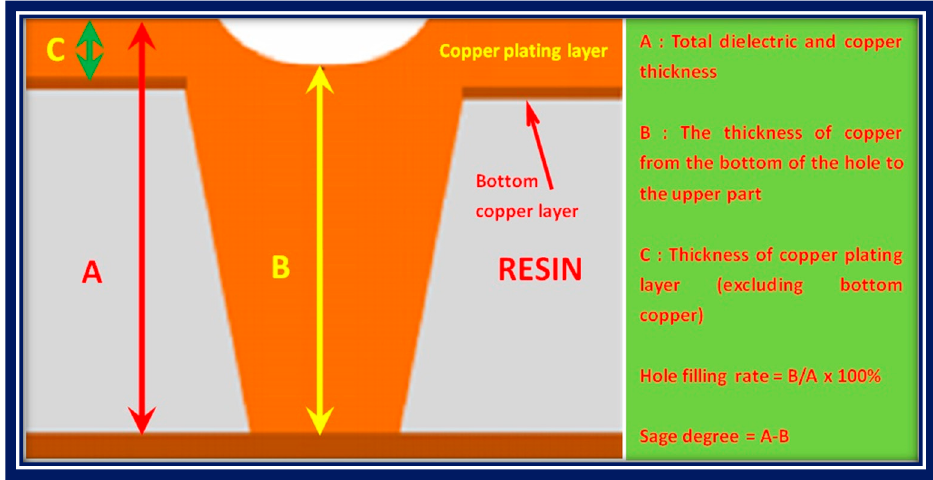
Figure 1. Characterization of the blind hole filling capacity.